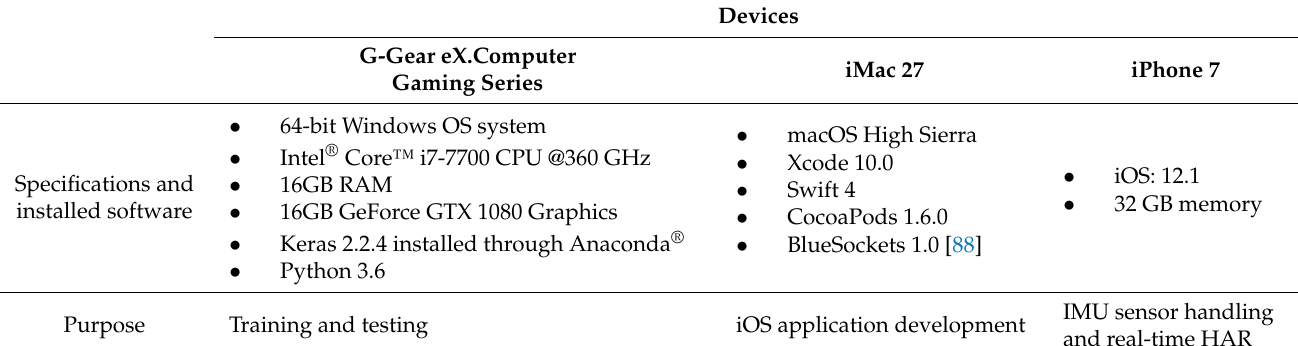
Table 1. Devices used for